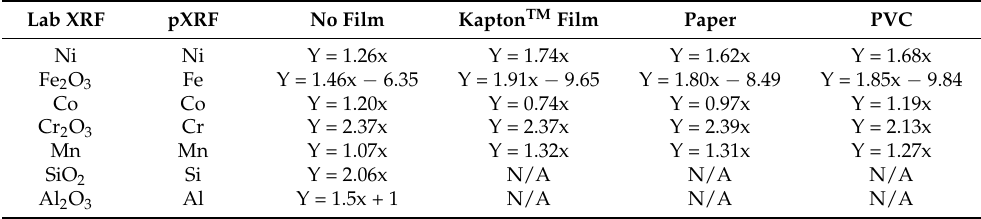
Table 2. Relationship between laboratory and pXRF analyses using different films for sample packaging